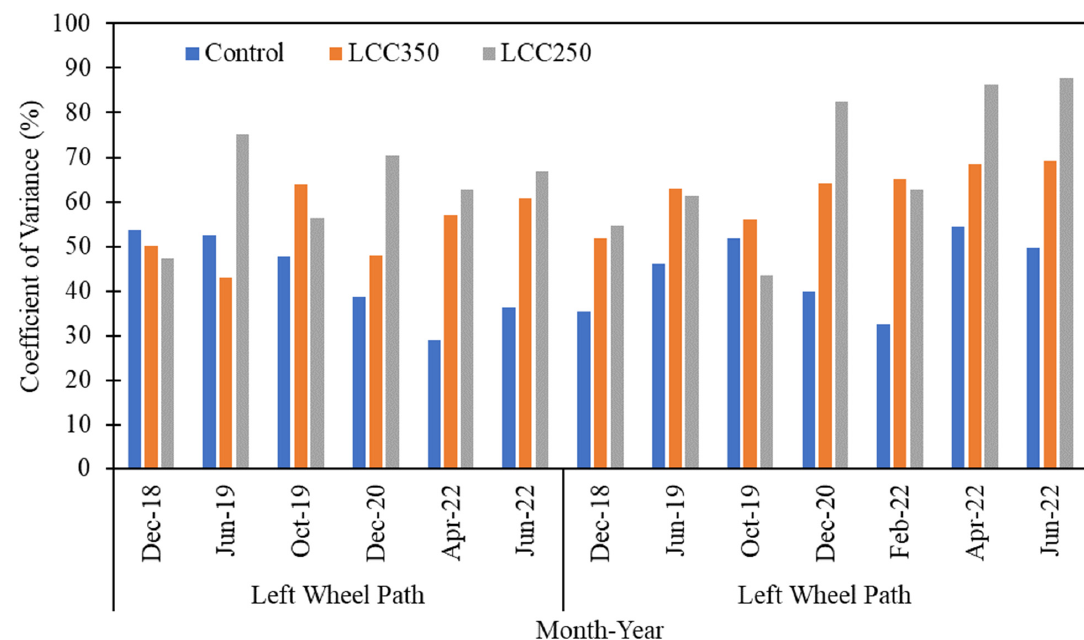
Figure 12. Erbsville measured IRI coefficient of variation from the mean.